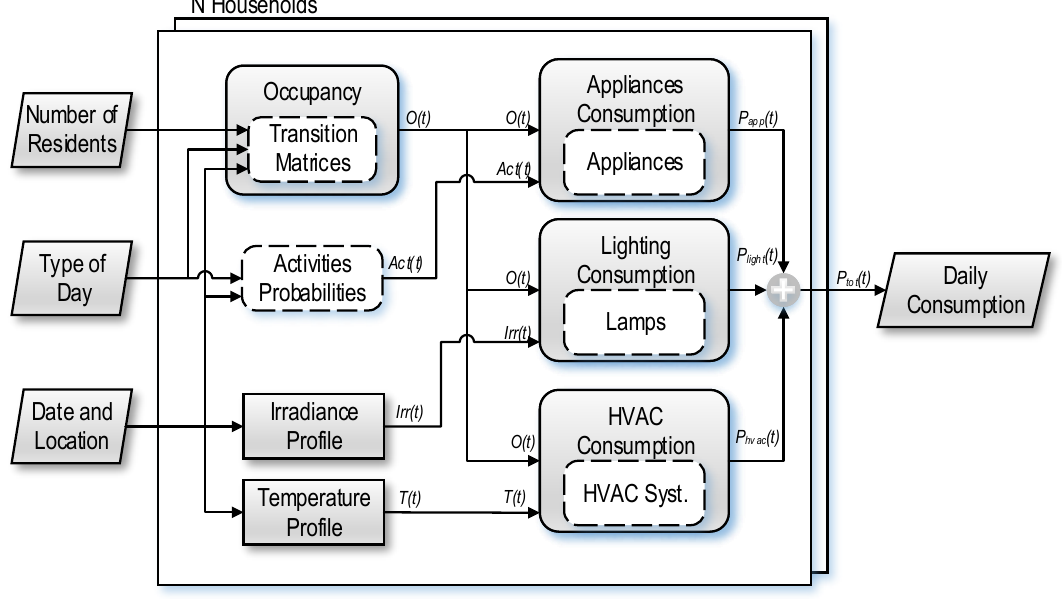
Figure 2. Conceptual architecture of the modeling and simulation